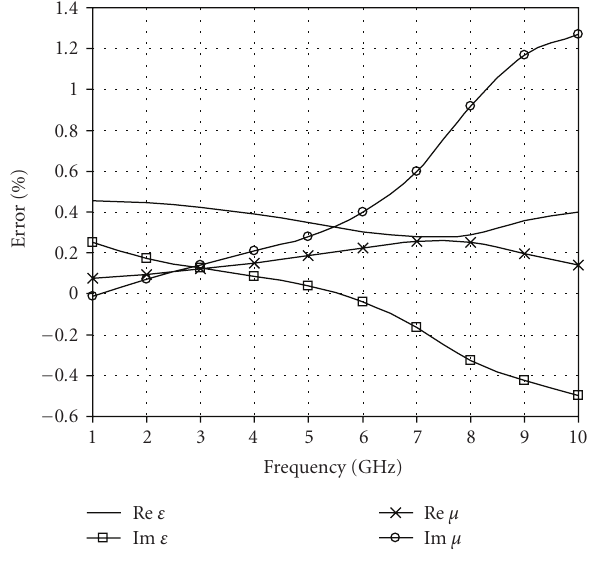
Figure 7: Higher mode propagation e ff ect.